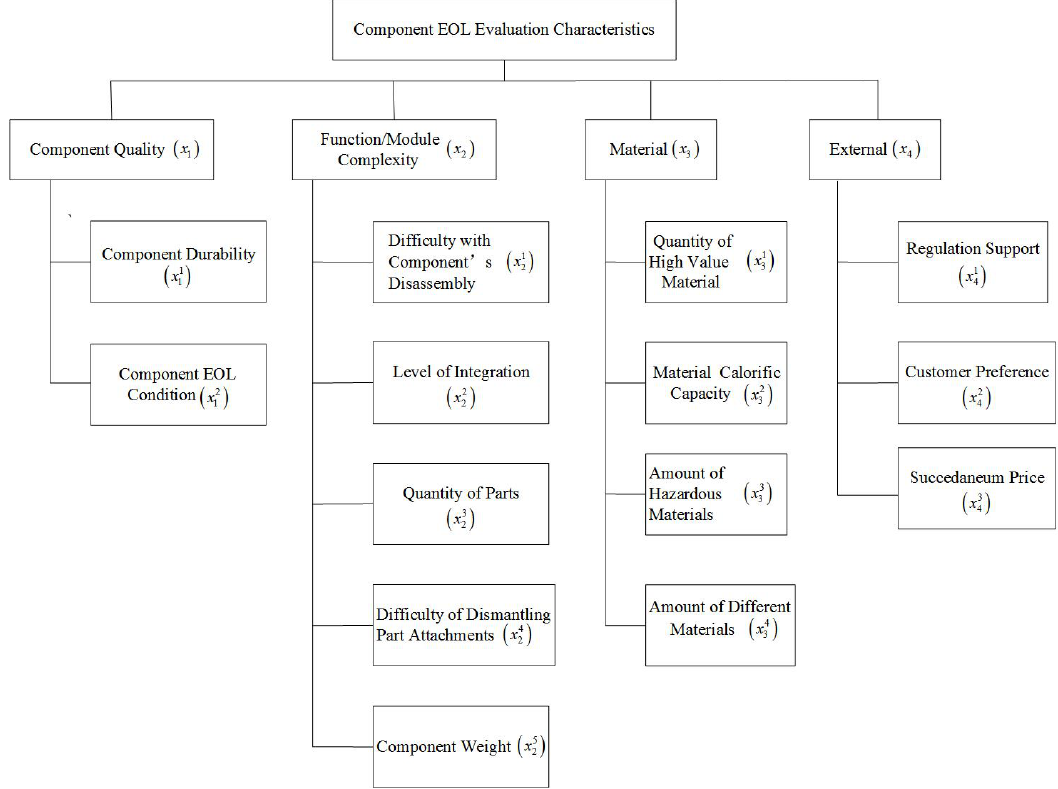
Figure 1. Structure of the decision